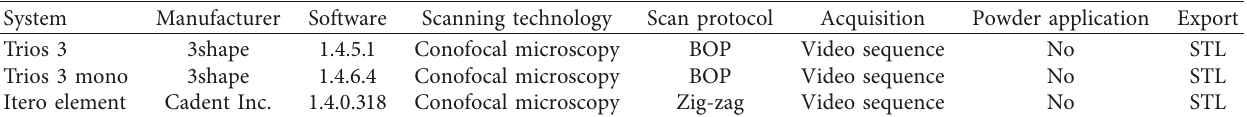
Figure 3: Study workflows. (1) Master model. (2) CMM measured the master model to obtain a true value. (3) Industrial Atos scanner digitized the master model 30 times. (4) Each intraoral scanner device (Trios 3, Trios 3 mono, and Itero) digitized the master model 30 Table 1: Information about the intraoral scanner systems.